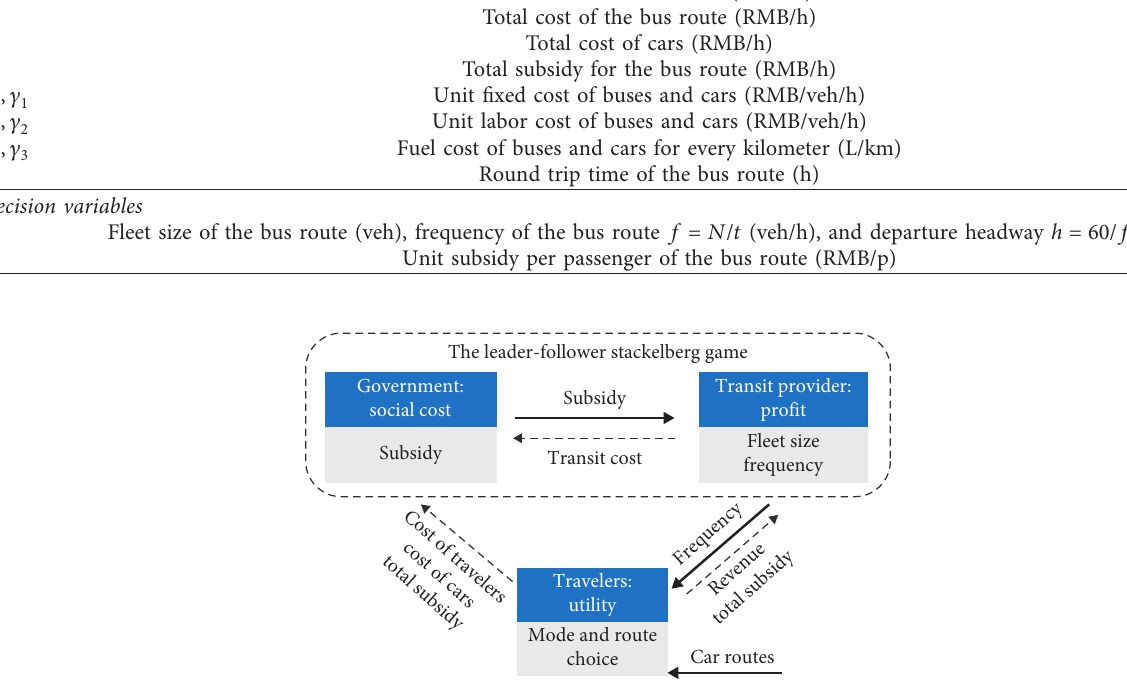
Figure 1: The leader-follower Stackelberg game between transit providers and